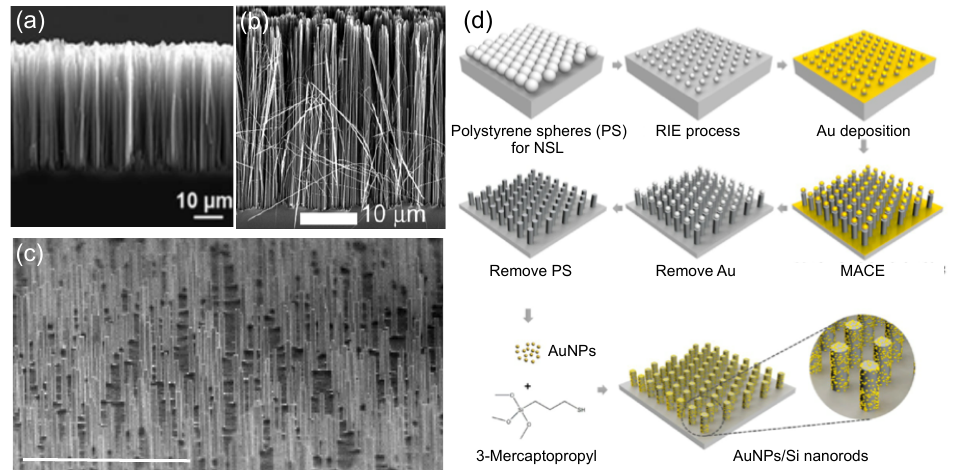
Figure 1. Three examples of metal-coated Si nanostructures (SEM images): ( a ) Si nanowires produced via a MACE technique (height h = 24.3 ± 1.9 µ m and nanowire diameter: 50 nm < D < 300 nm) coated with Ag nanoparticles (average AgNP diameter: d = 30 nm), reproduced from [31] with permission from the Royal Society of Chemistry; ( b ) Si nanowires produced through an Ag-assisted chemical etching of n -Si(100) wafer (height h ∼ 32 µ m and diameter: 80 nm < D < 200 nm), reprinted with permission from [37], Copyright 2010 American Chemical Society; ( c ) Au/Si nanopillars (NP) obtained with the fabrication technique based on an RIE process through the oxide native layer followed by a deposition of a gold layer of 30 nm (scale bar = 5 µ m, radius R ∼ 125 nm and height h ∼ 1000 nm); ( d ) principle scheme of the low-cost fabrication process combining NSL and MACE for producing AuNP-conjugated Si nanorod arrays (reprinted with permission from [63], copyright 2017 American Chemical